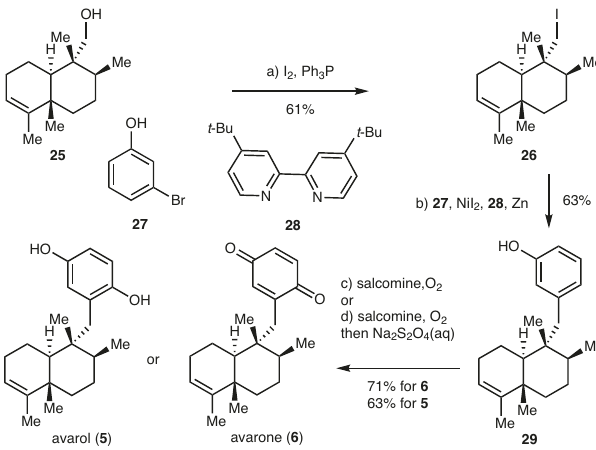
Fig.3|Synthesesofavaroneandavarol. Reagentsandconditions: a I 2 (2.0equiv), Imidazole (3.0 equiv), PPh 3 (3.0 equiv), benzene, 50°C, 12h, 61%; b 27 (3.0 equiv), NiI 2 (0.2 equiv), 28 (0.2 equiv), Zn (3.0 equiv), DMAc, 80°C, 2h, 63%; c salcomine (2.5 equiv),